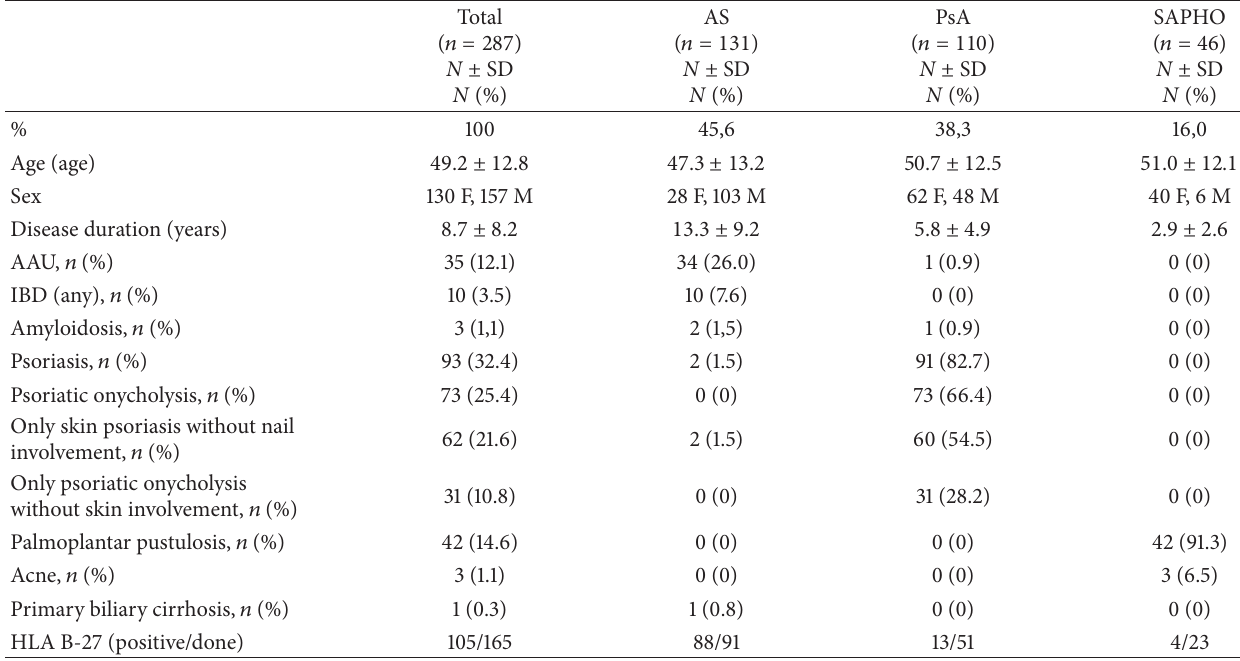
Table 1: The clinical characteristics and the percentage of extra-articular symptoms of spondyloarthritis